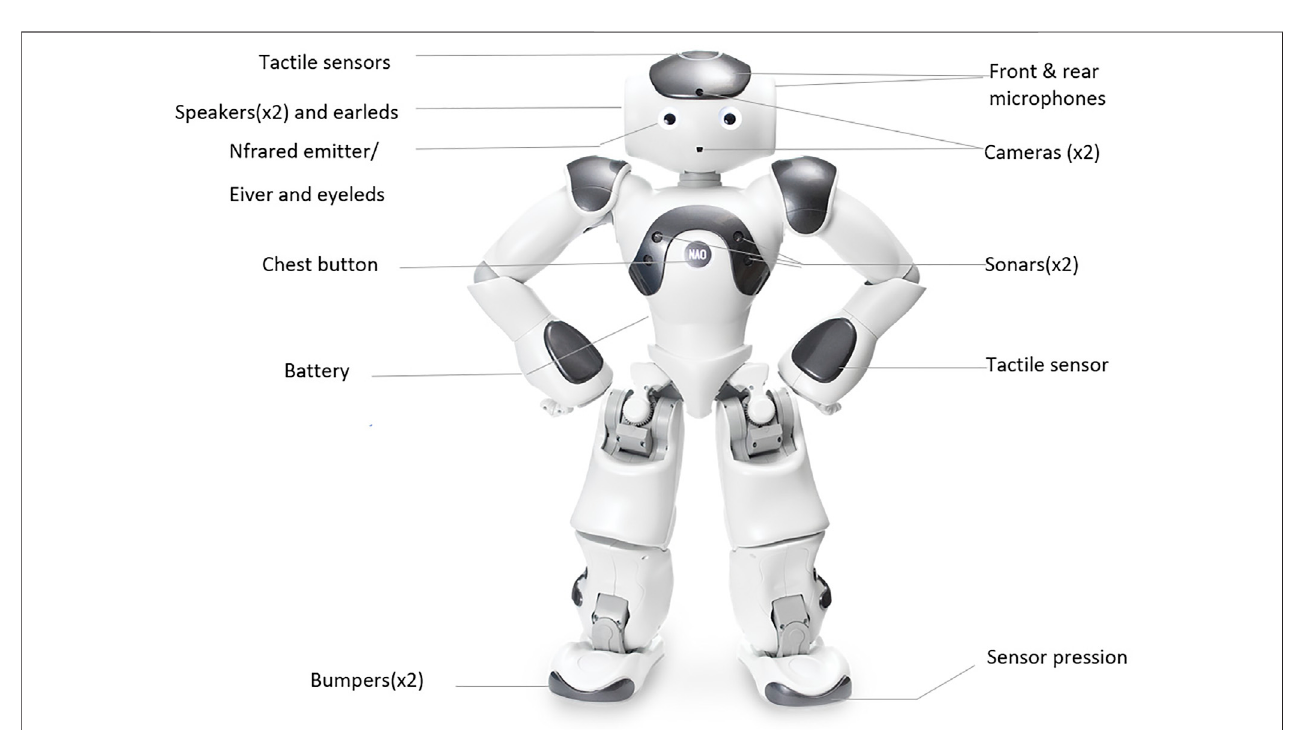
FIGURE 11 | Nao speci fi